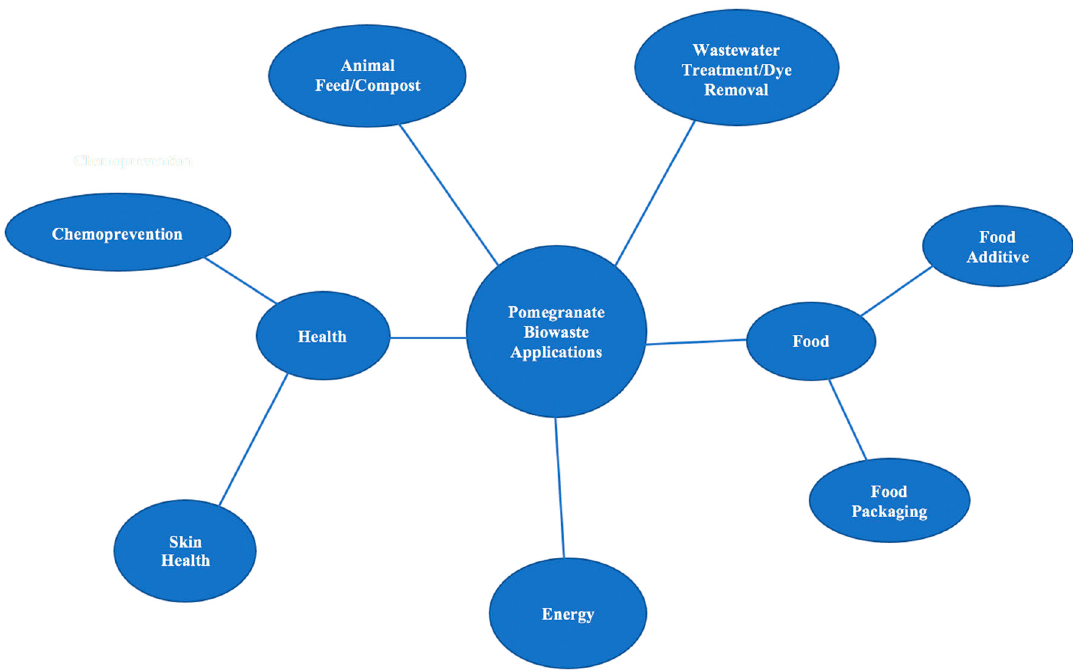
Figure 4. Applications of Pomegranate Biowaste.